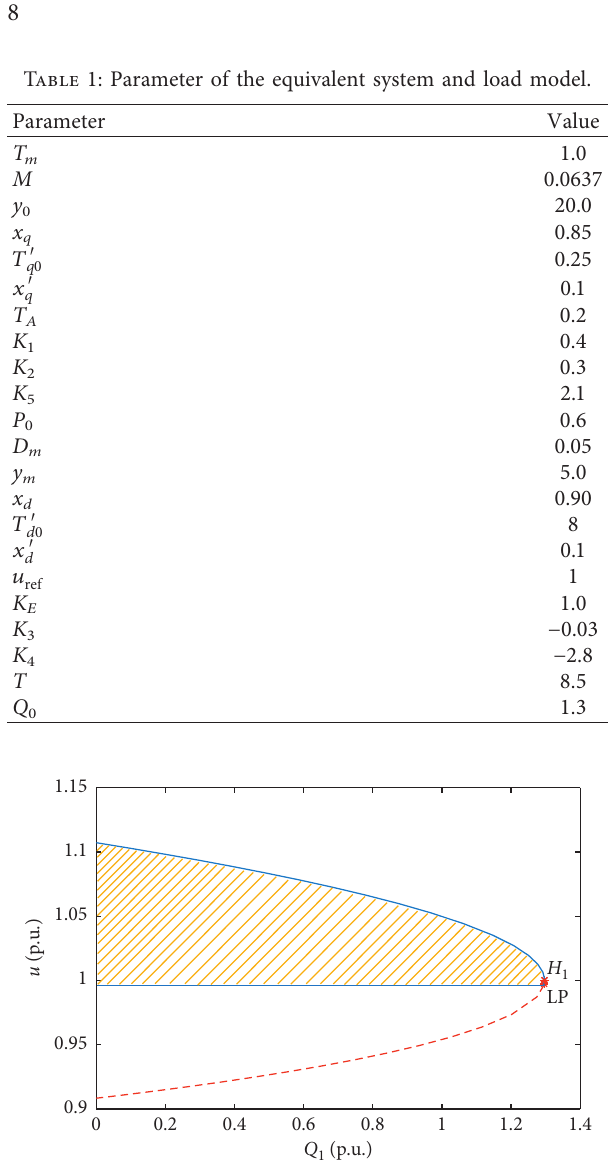
Figure 7: Q − u curve simulation diagram. 1 Table 2: The parameter value of each bifurcation point (in